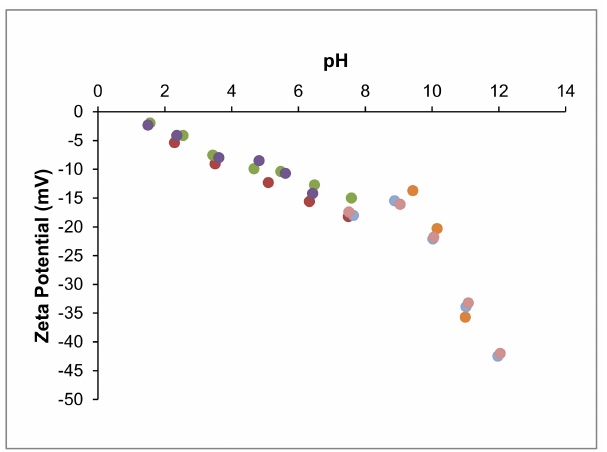
Figure 3. Zeta potential as a function of pH for the palygorskite (different series of measurements were performed, each one shown by a different